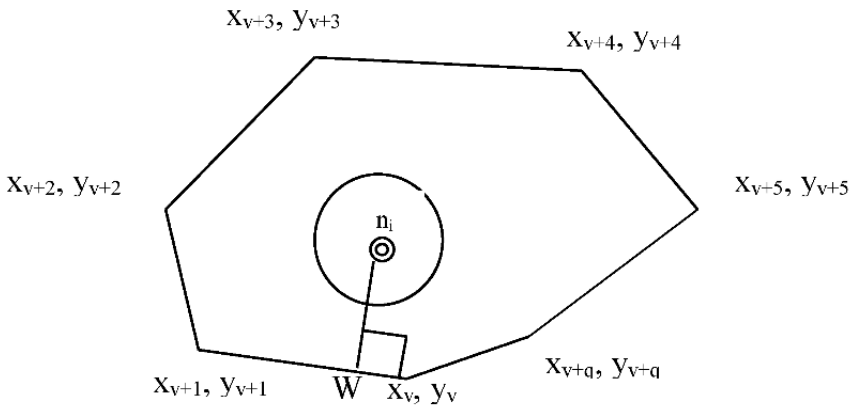
Figure 3. Polygonal zone and radio-circle embedding.